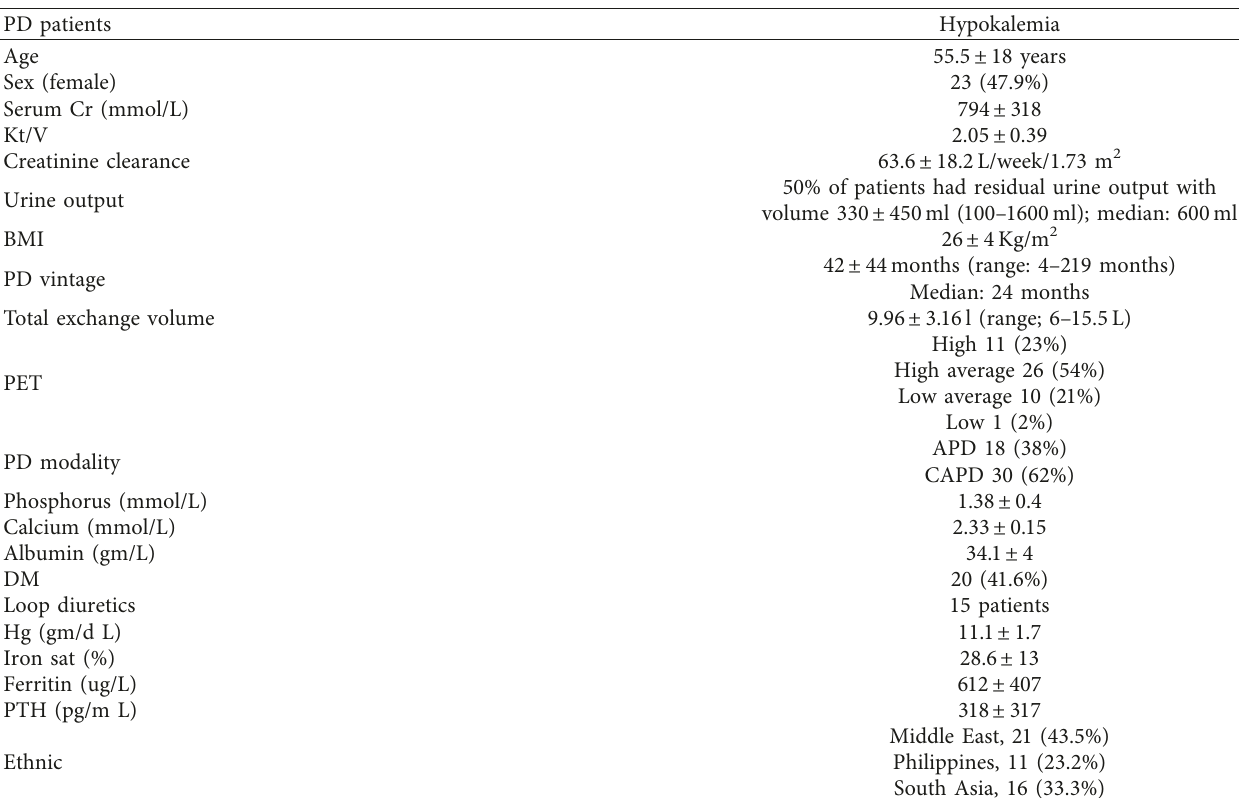
Table 1: Main demographic and biochemical features in PD patients with persistent